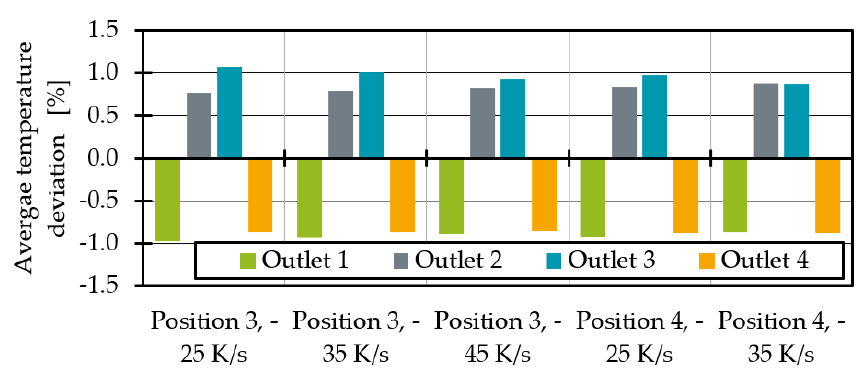
Figure 13. Average temperature deviation for different heat pipe performances and positions.